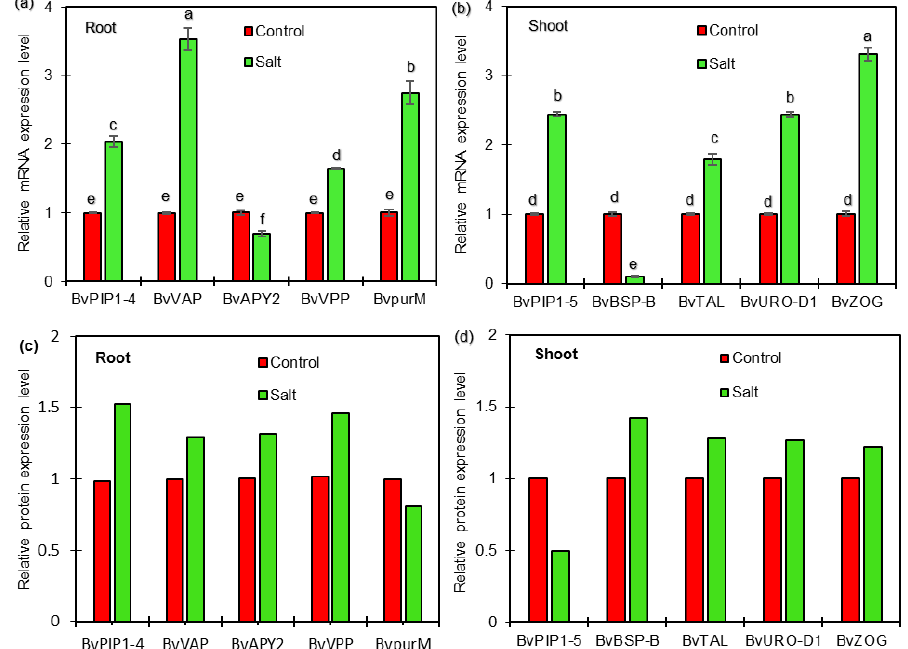
Figure 7. qRT-PCR expression analysis of selected genes with corresponding protein change in roots ( a , c ) and shoots ( b , d ) of sugar beet plants exposed control and 50 mM NaCl for 72 h. Relative mRNA levels in salt-treated plants were normalized against the control plants. Values are mean ± SE of three independent experiments. Columns with different letters indicate significant differences at p <0.05 (Duncan’s test). The relative protein expression levels of selected protein were derived from proteomics data of the present iTRAQ-based experiment. The selected proteins were BvPIP1-4 (Unigene0033986), BvVP (Unigene0011701), BvpurM (Unigene0024368), and BvVAP (Unigene0010790) in roots; BvPIP1-5 (Unigene0033990), BvTAL (Unigene0005386), BvURO-D1(Unigene0000482) and BvZOG (Unigene0016372) in shoots, respectively. BvACTIN was used as an internal control to normalize the transcript levels of all expression